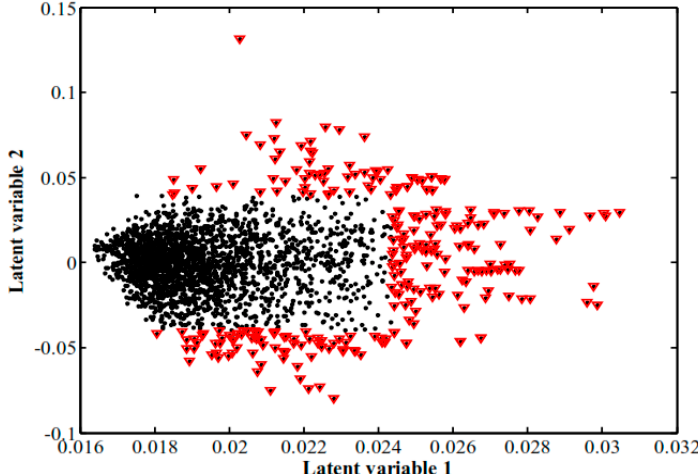
Figure 5. The most significant peaks based on high and low scores identified on the partial least square discriminant analysis (PLSDA) loading plot. In order to determine the most important metabolites, 142 peaks were selected (red triangles). These peaks showed the greatest influence on the classification of samples, as they were placed in the lowest and highest values of latent variables 1 and 2. The cut off line was calculated based on the formula: V − V ≥ α × σ . Heat maps were used for data visualization [32–34]. Based on the heat map analysis, all